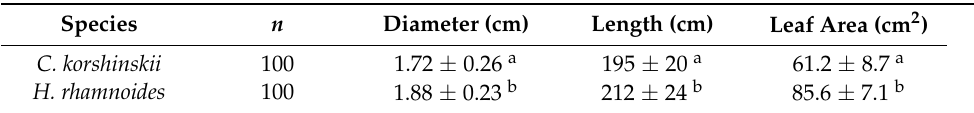
Table 3. The characteristics of the 100 selected branch samples and 100 stem samples of C. korshinskii and H. rhamnoides in the scale-up